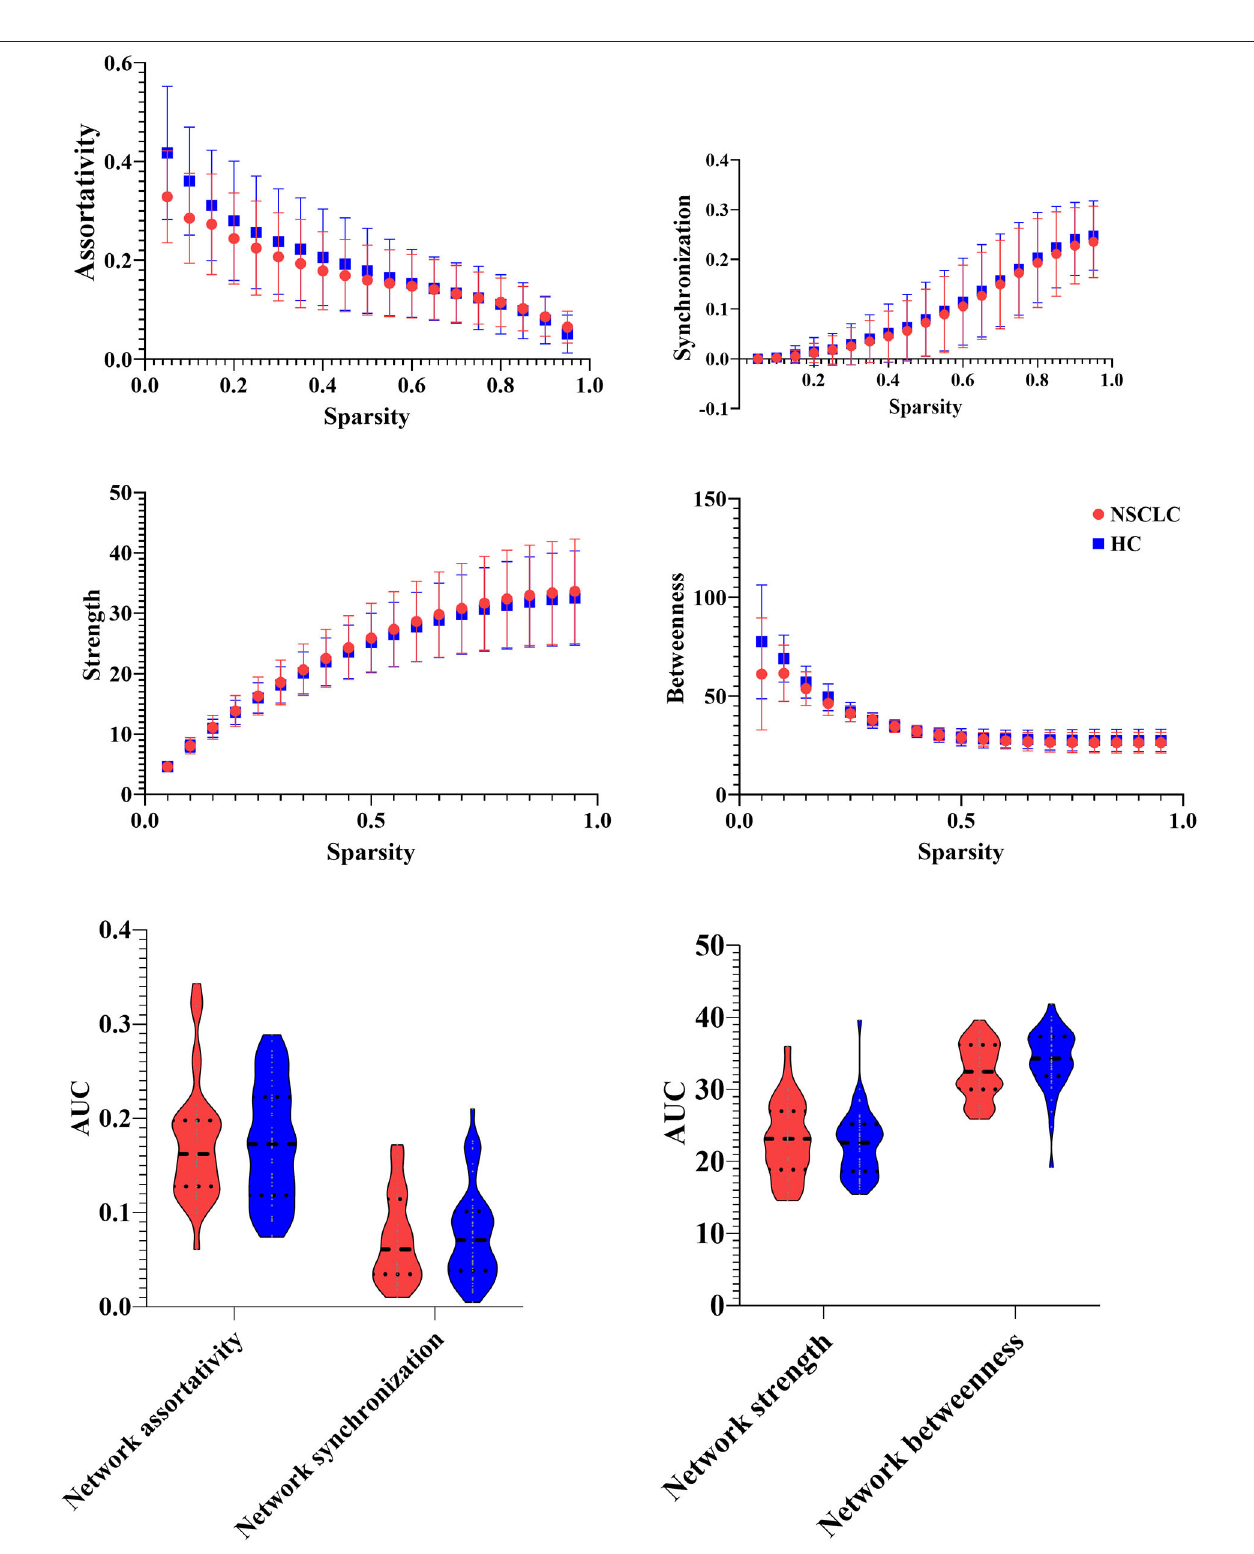
FIGURE 2 | Group differences in the network measures of the functional brain networks among different sparsity thresholds (0.05–0.95) between the groups.